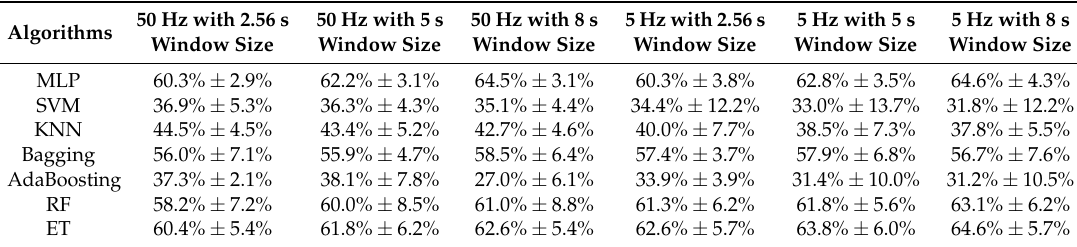
Table 3. Cross-validation accuracy and standard deviation for the classification algorithms trained for different window sizes.